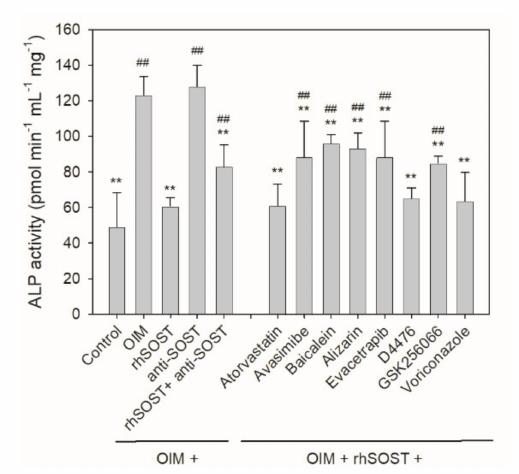
Figure 6. Effect of the potential sclerostin inhibitors on rescuing suppressed ALP activity caused by exogenous sclerostin. Recombinant human sclerostin (rhSOST) was incubated with 1 µ M of the chemical compound for 30 min prior to incubation with hBMSCs for 3 days. After refreshing the medium with OIM, the cells were cultured for another 4 days before ALP activity was determined. Error bars represent standard deviations ( n ≥ 3). ## p < 0.01, compared to the control; ** p < 0.01, compared to the OIM